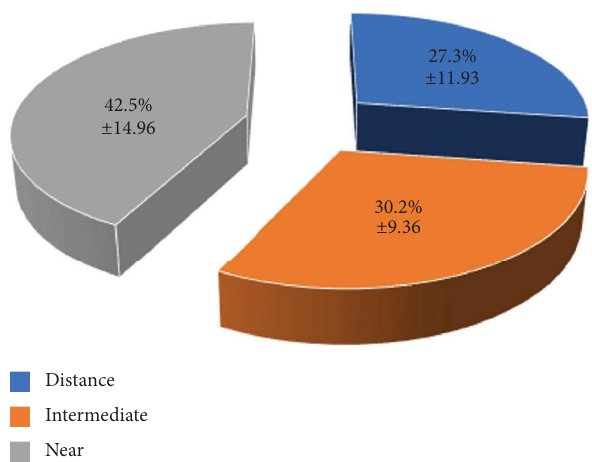
Figure 1: Mean percentage of the time dedicated to distance, intermediate, and near visual activities measured in the evaluated